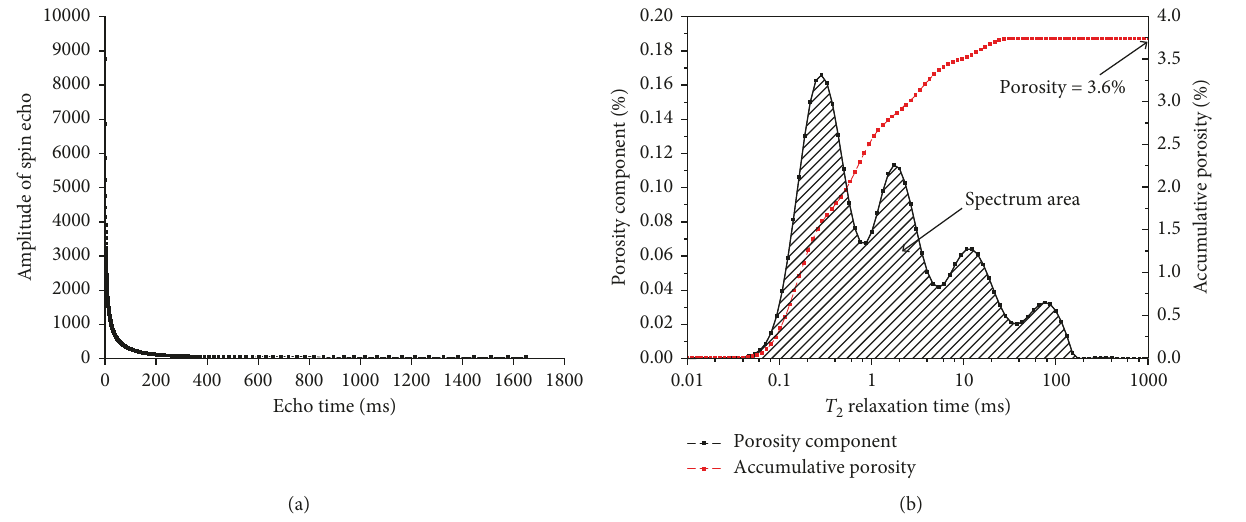
Figure 2: Results of NMR analysis: (a) echo signal decay curve; (b) T